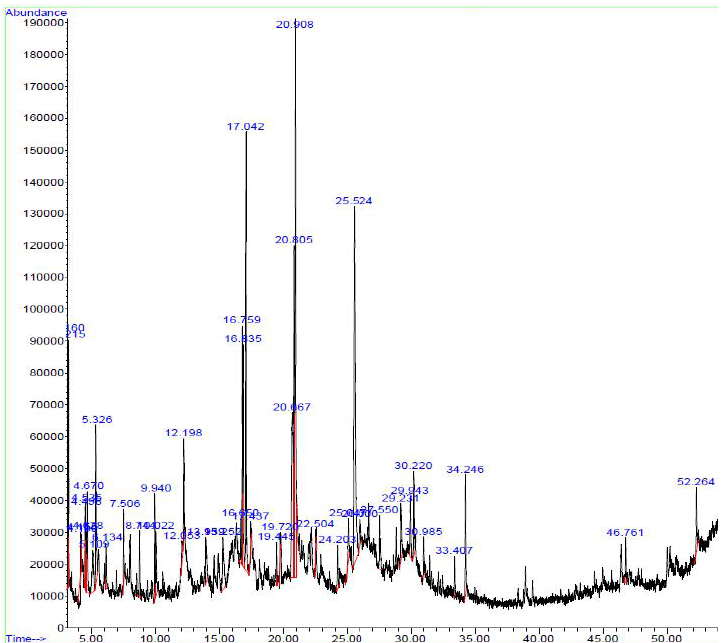
Fig 2. GC-MS chromatogram of Thymus vulgaris extract (Heidari et al.,